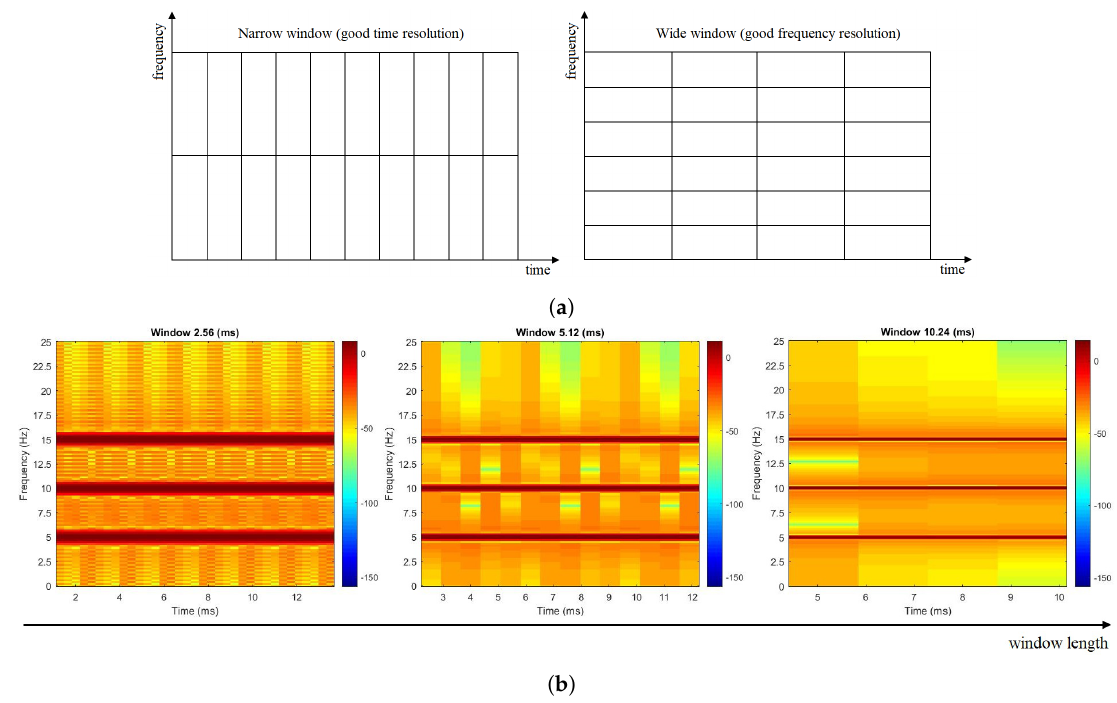
Figure 6. Short Time Fourier Transform (STFT) time–frequency resolution. ( a ) Narrow vs. Wide window ( b ) Example of time-frequency resolution for increasing window